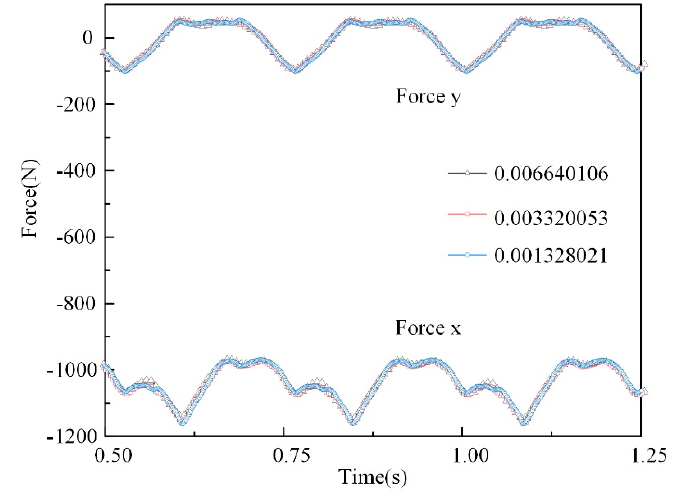
Figure 3. Time step independence test.